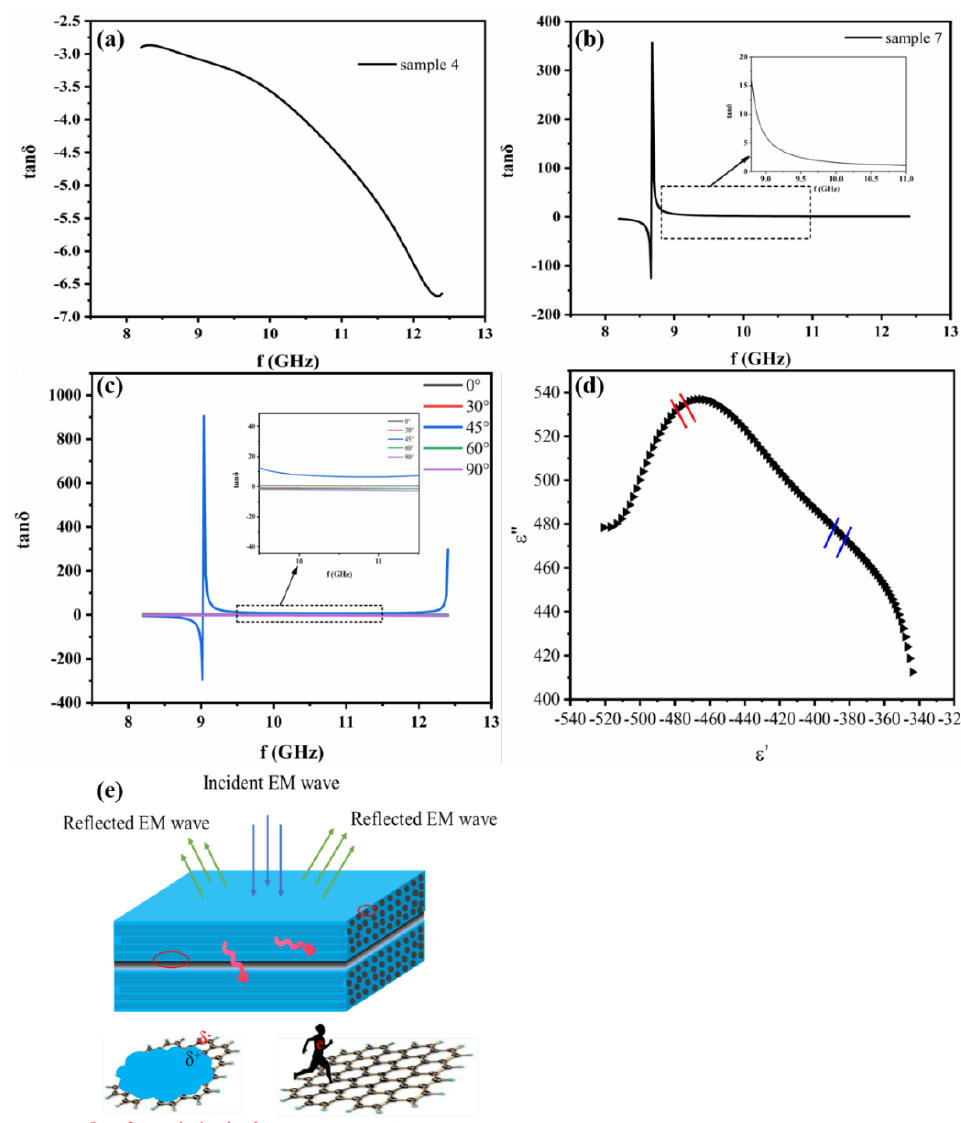
Figure 6. Dielectric loss tangent tan δ of ( a ) samples 4, ( b ) samples 7, and ( c ) samples with different α , ( d ) Cole-Cole semicircle of sample with α of 45 ◦ and ( e ) schematic diagram of electromagnetic wave loss